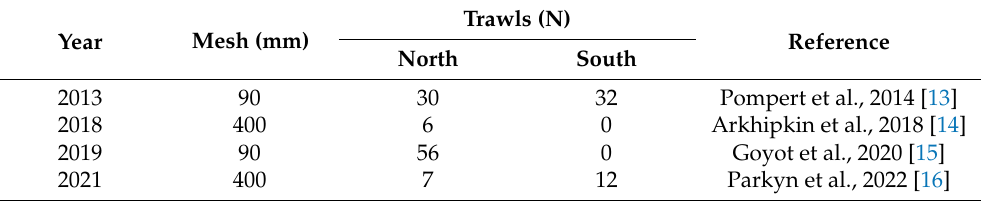
Table 1. Summary of skate trawl surveys, corresponding to Figure